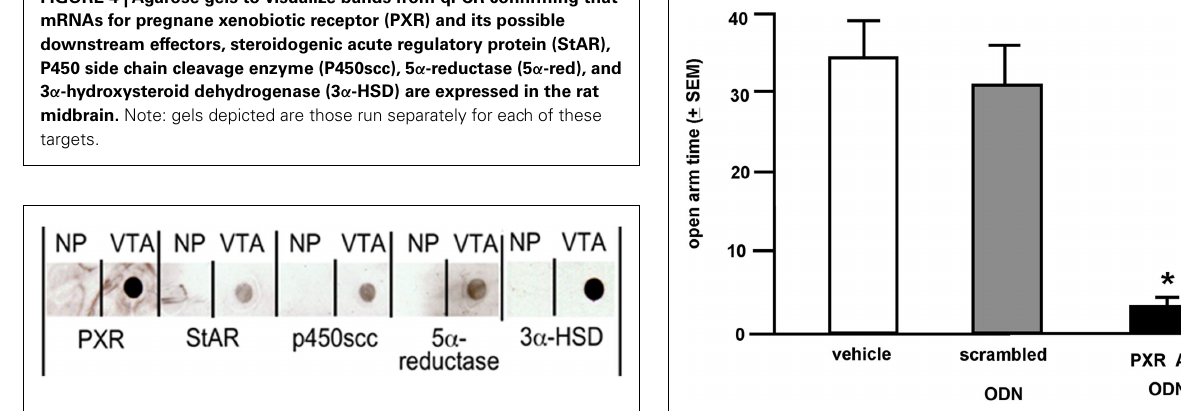
FIGURE 7 |Affective behavior in the elevated plus maze of E 2 -primed rats administered scrambled control or pregnane xenobiotic receptor (PXR) antisense oligodeoxynucleotides (ODNs) to the midbrainVTA. ∗ Indicates different from all groups, p <